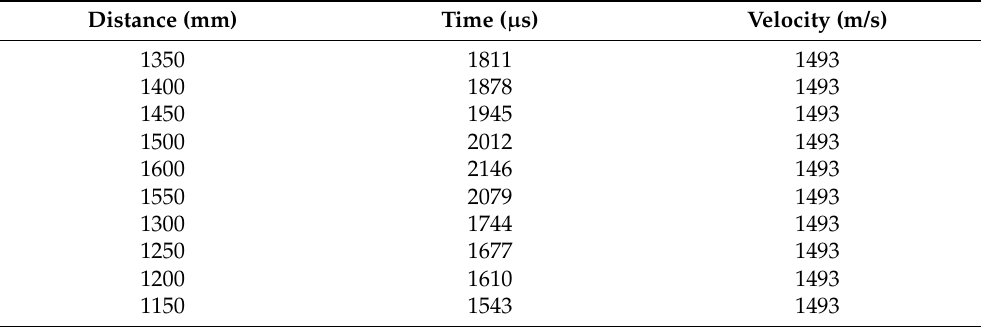
Table 4. Time and acoustic propagation speed of the echo received by probe No. 2 at different